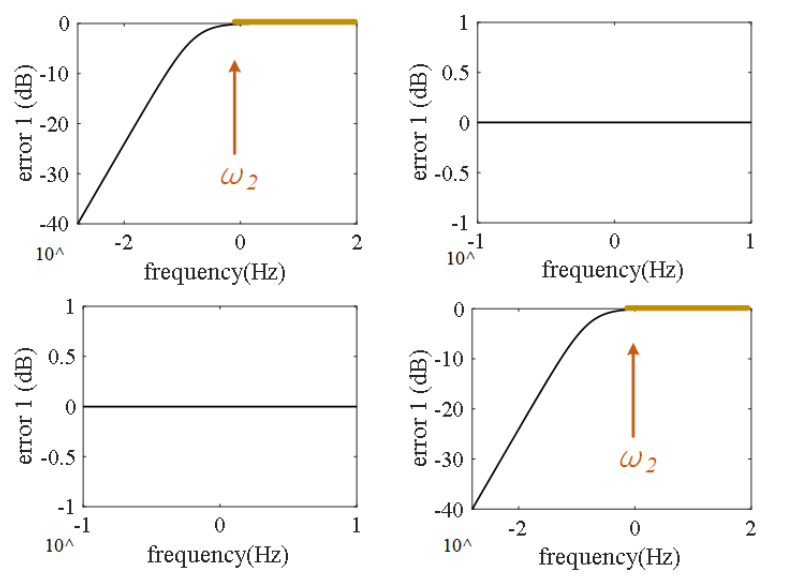
Figure 5. Sensitivity of We −